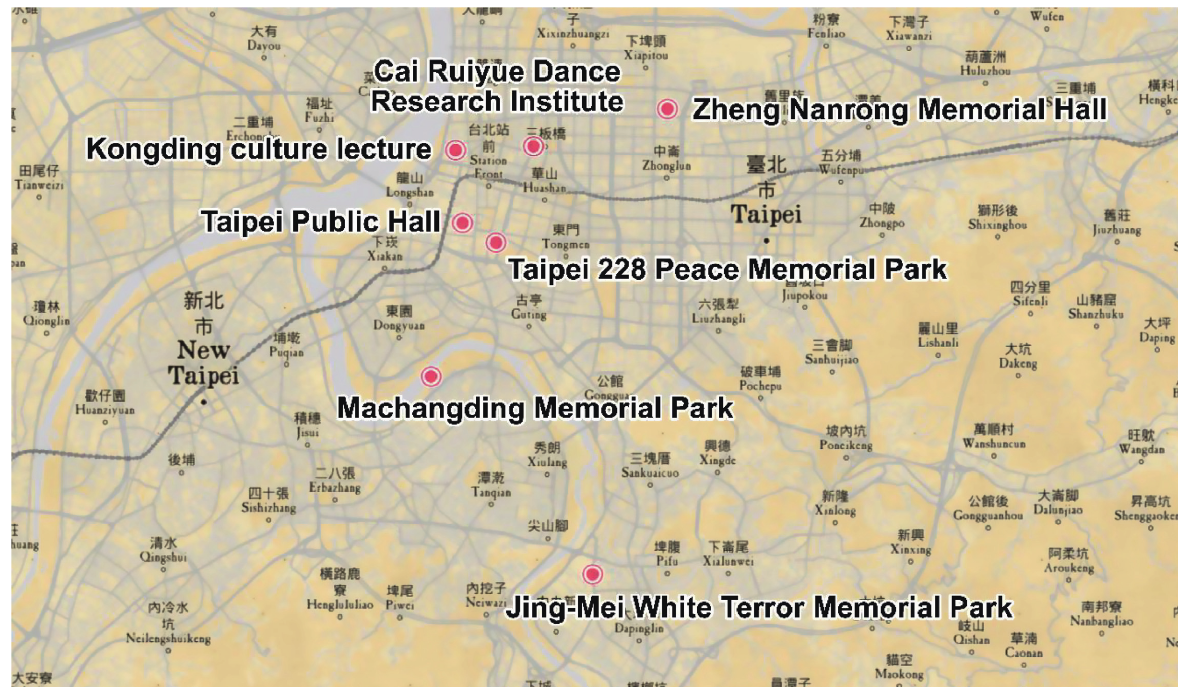
Figure 5: Human rights-themed cultural corridor in